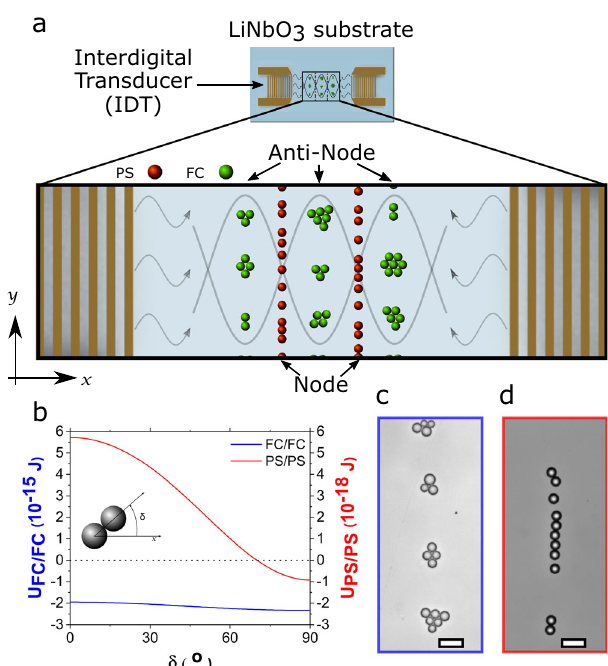
Fig. 3 Liquid PFH droplet clustering and radiation forces. a Schematic of the SAW device shown with the assembly type and location of liquid PFH droplets and the PS beads of similar sizes. b Secondary interaction energy between two contacting PFH droplets (red line, Eq. 4) and PS beads (blue line, Eq. S3) with orientation angle δ with respect to wave propagation direction, i.e., x-axis. Positive values indicate repulsion and negative values indicate attraction. Source data are provided as the source data fi le. c Assembly of liquid PFH droplets under 1D standing SAW compared to the assembly of PS particles under 1D standing SAW (shown in d ). Note that PS particles form chains whereas PFH particles forms clusters as shown by b . Scale bar, 20 μ